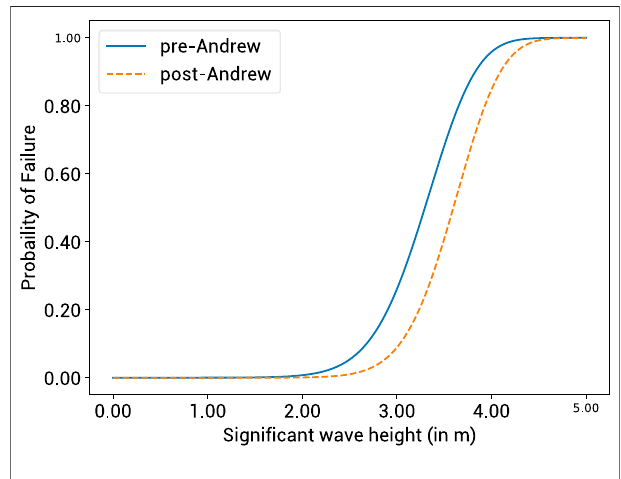
FIGURE 6 | Fragilities of residential buildings, wave velocity Vw (cid:1) 0.18 m/s.